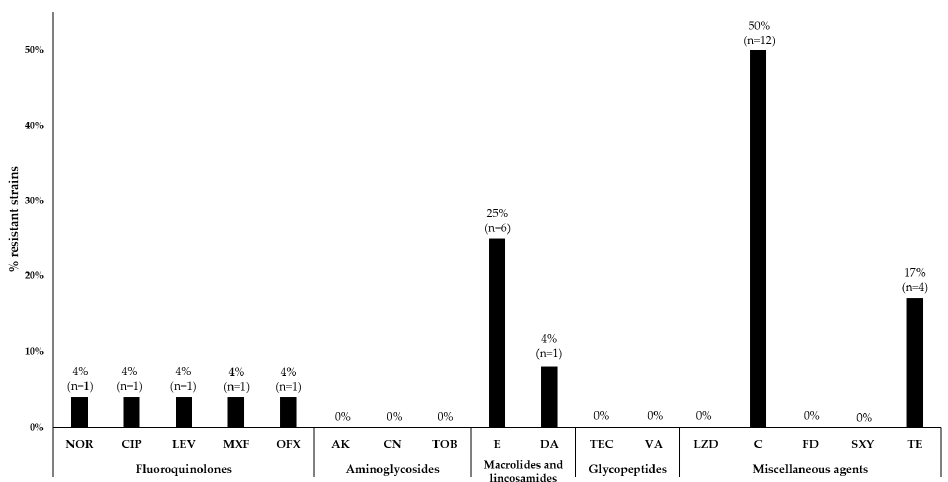
Figure 1. Percentage of S. aureus resistance to specific antibiotics. Abbreviations: NOR—norfloxacin; CIP—ciprofloxacin; LEV—levofloxacin; MXF—moxifloxacin; OFX—ofloxacin; AK—amikacin;